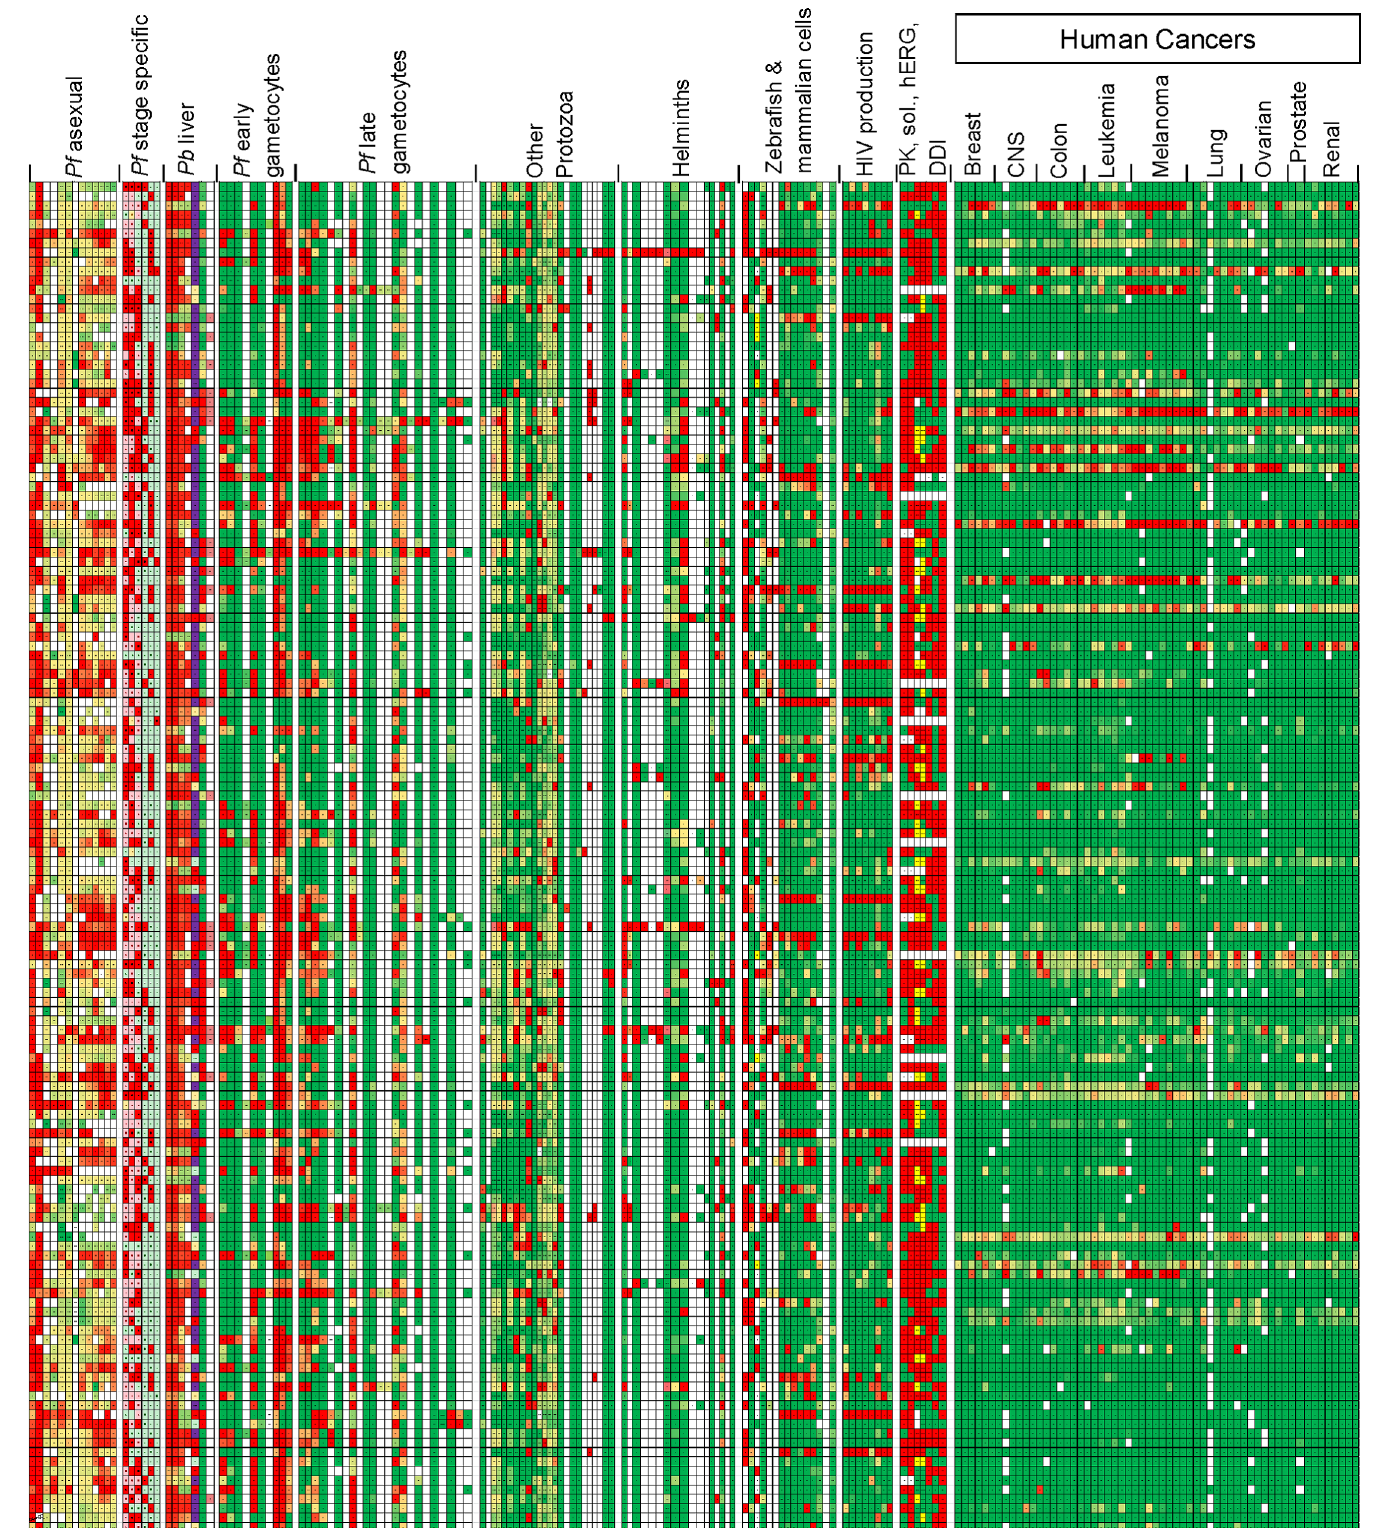
Fig 1. Malaria Box Heatmap. Shown are selected data from the HeatMap (S1 Table) for the 400 Malaria Box compounds. Each column represents an assay (grouped by category), compounds are represented in rows. The red-green gradient represents higher to lower activity. Favorable PK activities